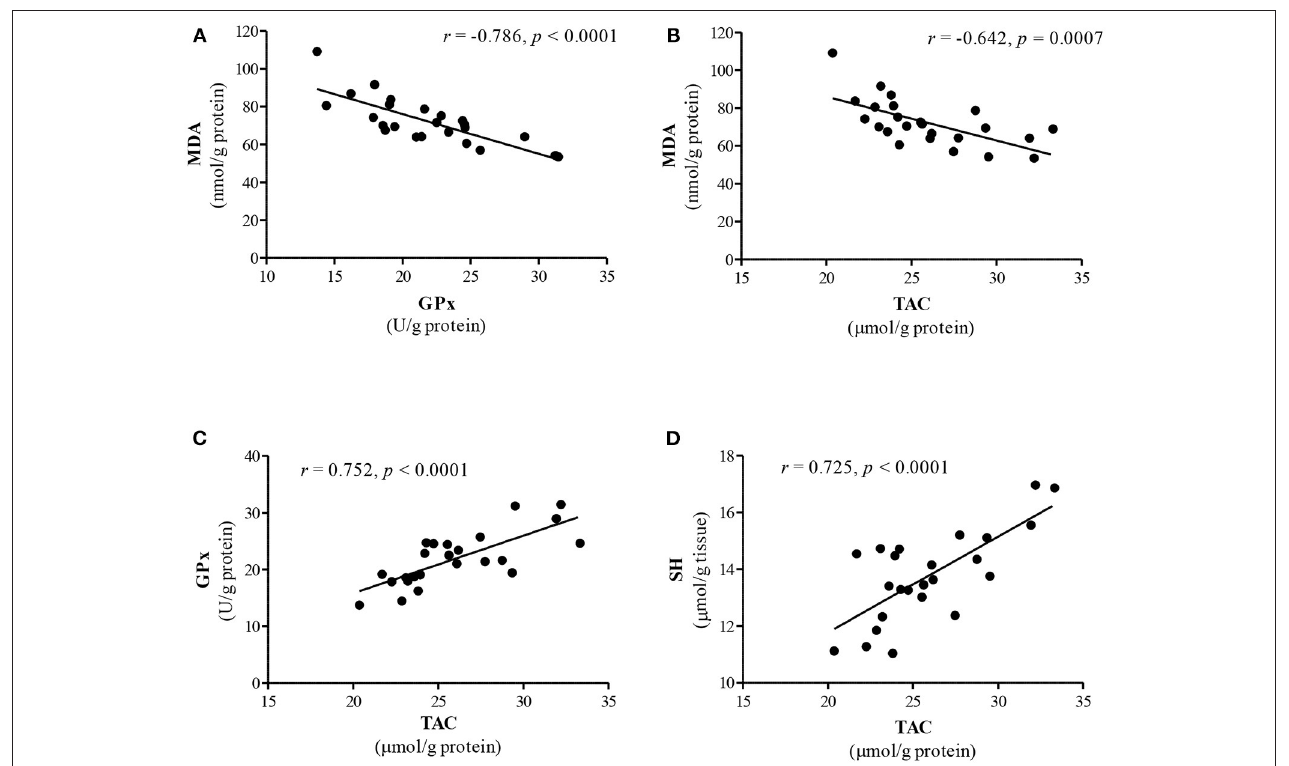
FIGURE 1 | The interrelationship between lipid peroxidation and antioxidant parameters in the kidney. (A) MDA level vs. GPx activity; (B) MDA level vs. TAC; (C) TAC vs. GPx activity; (D) TAC vs. SH groups. Data analyzed using Pearson’s correlation test and presented as a correlation coefficient ( r ).